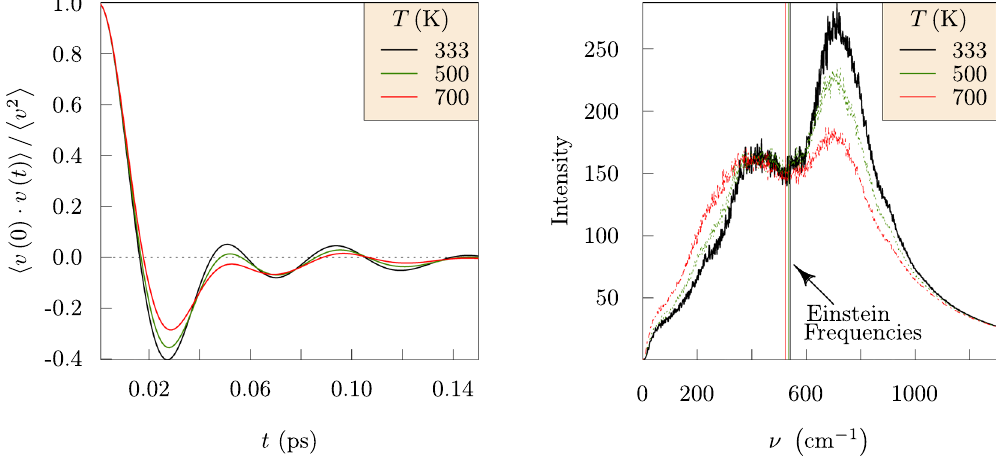
Figure 8. Velocity auto-correlation functions (left) for Li + in EDC at different temperatures. Power spectra (right) for Li + in EDC. Vertical lines near 570 cm − 1 are Einstein frequencies (Eq. 7) of these ionic motions. The power spectra identify two prominent vibrational bands, near 400 cm − 1 and 700 cm − 1 . The intensities of the high frequency modes diminish with increasing temperature.